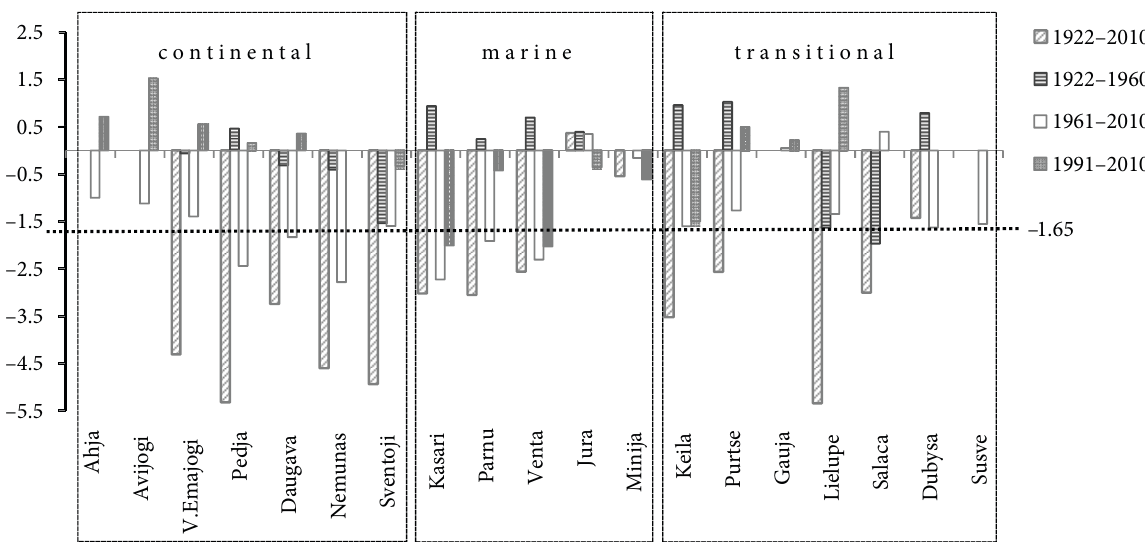
Fig. 5. Trends (according to trend statistics) of annual maximum discharges of spring floods in rivers of different type